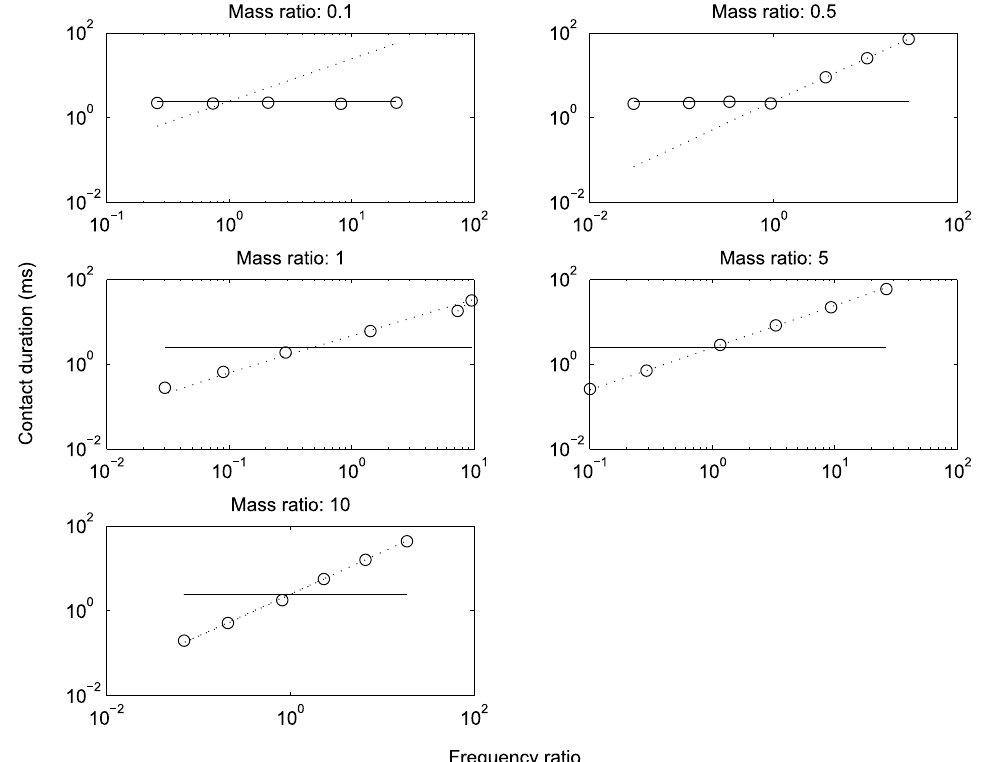
◦ Fig. 6. PF beam against PP beam – Impact duration sensibility: “ ”: fi rst impact duration; solid line: 1 / 2 T AO PP ; doted line: 1 / 2 T AO PF . are adjustable parameters to make the AO parameters vary. Each beam is impacted at its